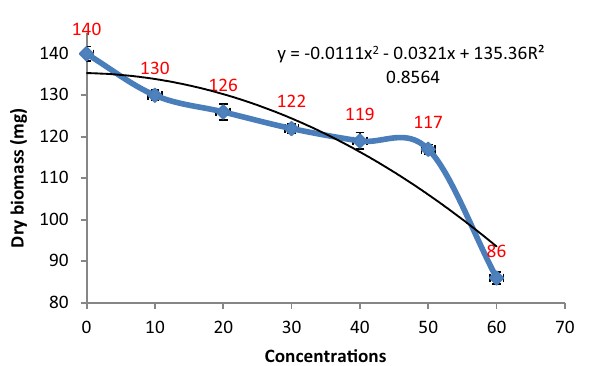
Figure 2. Effect of different metabolite concentrations of P. janczewskii on the biomass production of P. herbarum. Vertical bars show standard errors of the means of three replicates.